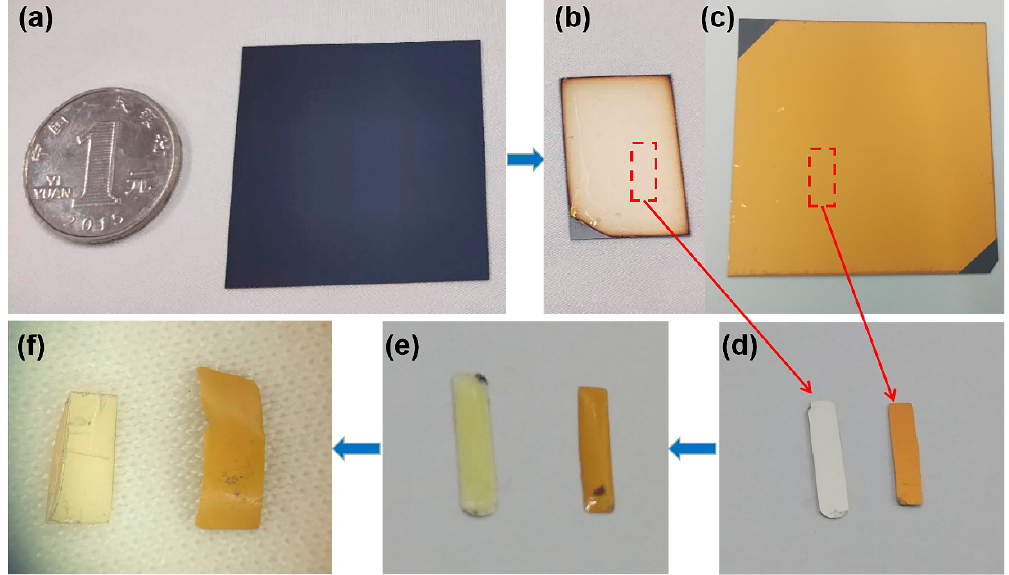
Figure 1. ( a ) Regular surface textured crystalline silicon solar cell substrate; ( b ) Au/PPS; ( c ) Ag/PPS; ( d ) Au/PPS; and Ag/PPS after cutting; ( e ) UVcp was applied to ( d ); ( f ) the Ag/IPS and Au/IPS.